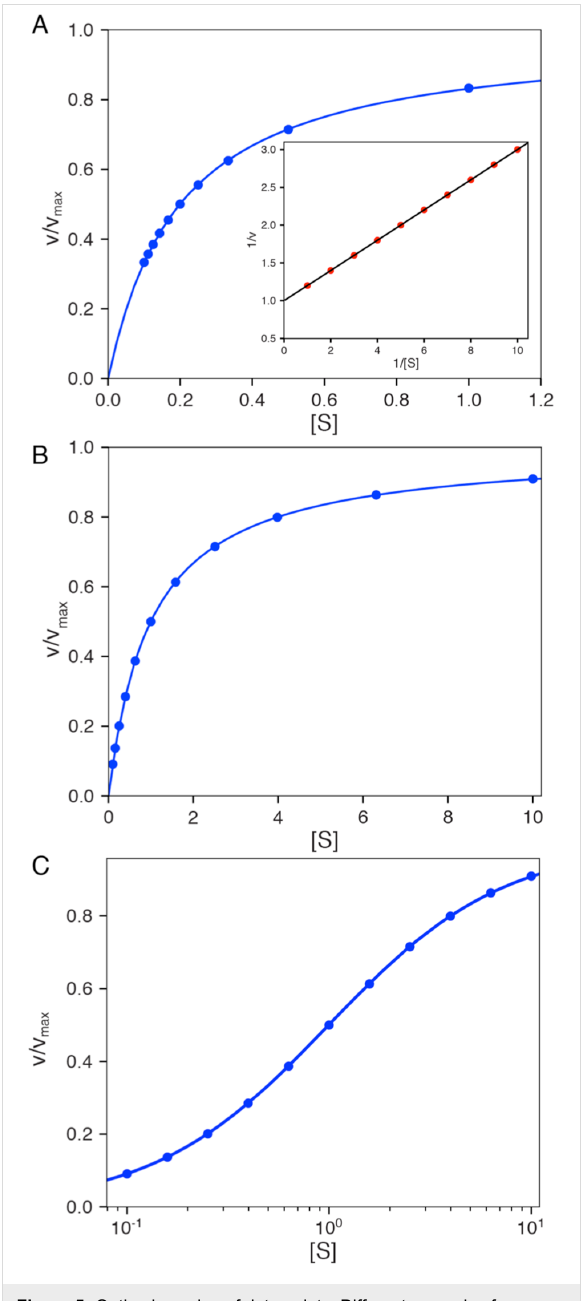
Figure 5: Optimal spacing of data points. Different scenarios for computing the distribution of data points for steady state measure- ments are shown. A) Linear distribution on a double reciprocal plot. Sample data were calculated with k cat = 1 s − 1 and K m = 0.2 (arbitrary units). The inset shows the same data on a double reciprocal plot. B) Logarithmic distribution of data points. Sample data were calculated with k cat = 1 s − 1 and K m = 1 (arbitrary units). C) Data in B on a loga- rithmic x -axis. The smooth lines show the fitted